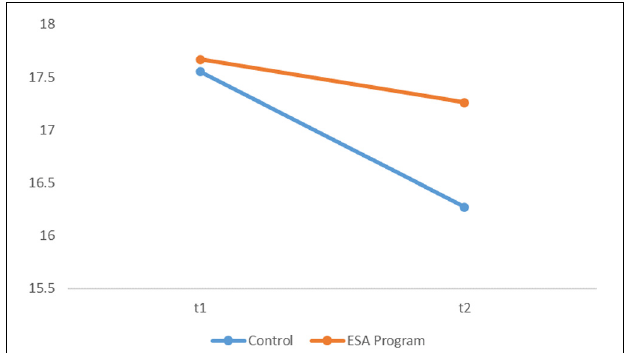
FIGURE 1 | Intrinsic motivation for ESA Program and control group.